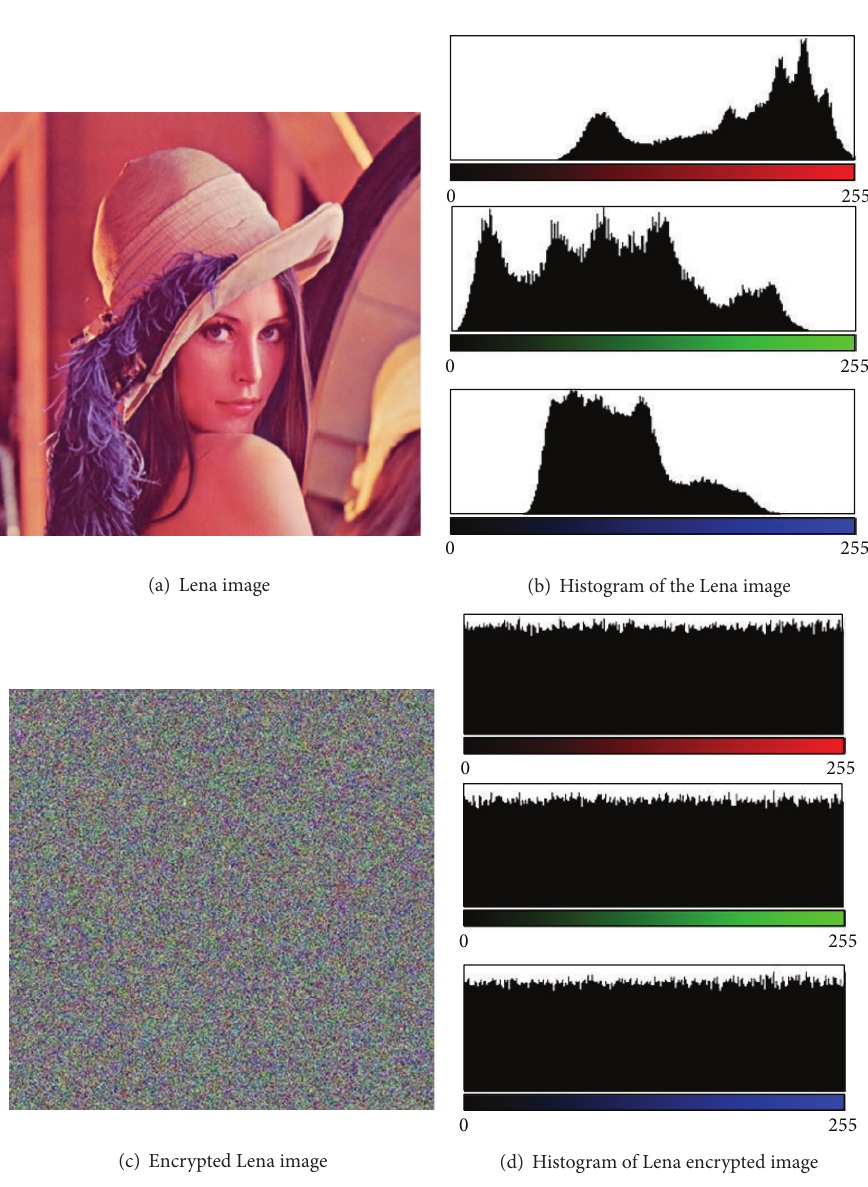
Figure 9: Analysis of the standard image